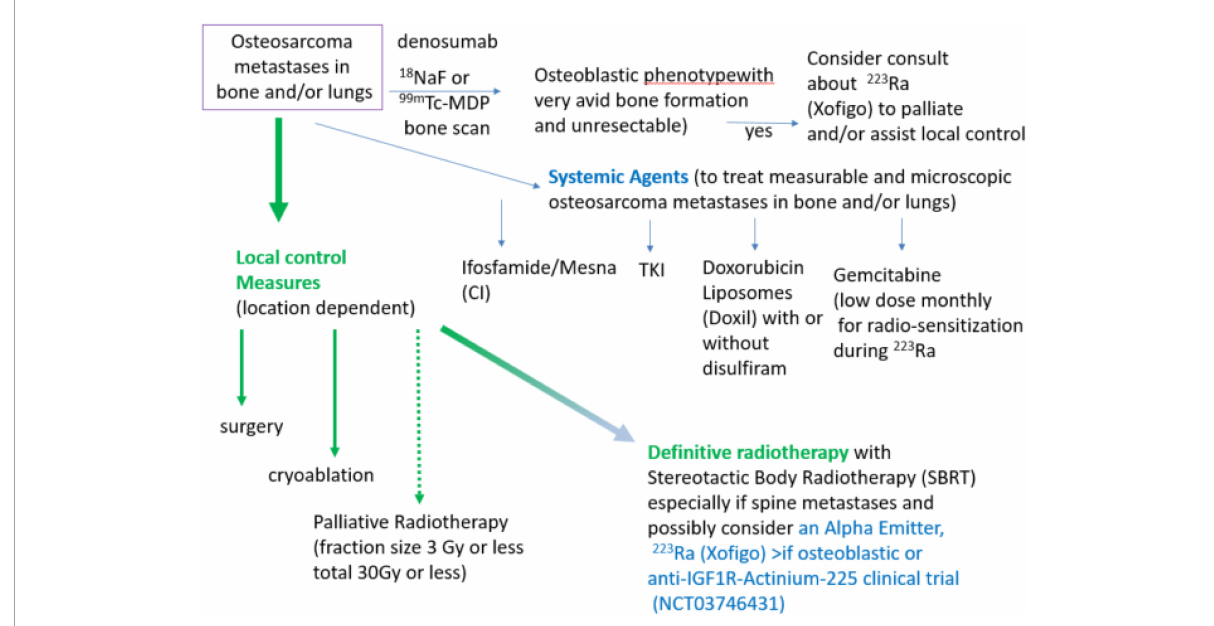
FIGURE2 Top shows 99 m Tc-MDP screening bone scan with avid uptake indicating suitability for alpha particle therapy with the bone-seeking radiopharmaceutical, 223 RaCl 2 (Xofigo). 223 Ra (blue), then gemcitabine (green) next day + monthly denosumab 6 × monthly cycles resulted in improvement, then resolution of symptoms of the unresectable mediastinal and vertebral body osteosarcoma. Currently, the patient is on